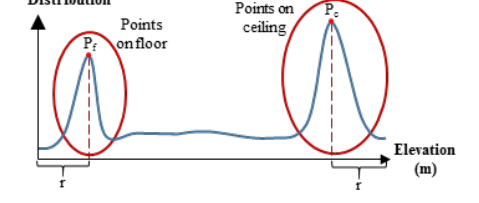
Figure 5. Expected distribution of the elevation of the